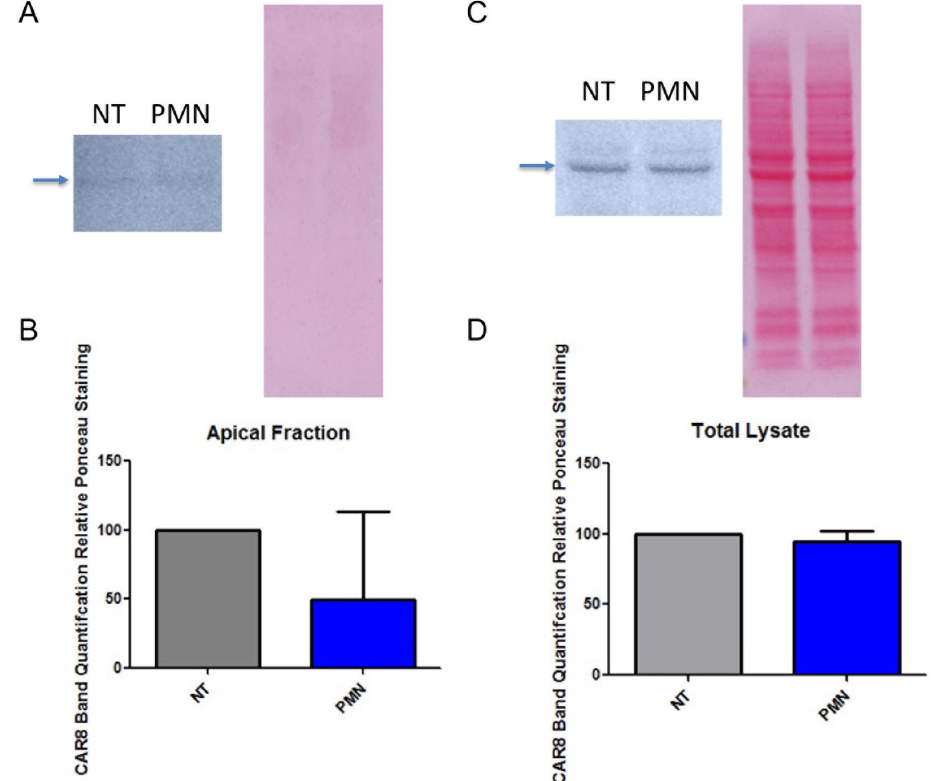
Figure 2. PMN exposure does not significantly change apical or total expression of CAR Ex8 in MDCK-CAR Ex8 epithelia. MDCK-CAR Ex8 cells were grown in 6-well transwell inserts until they were fully polarized and then exposed to PMN. Apical surface proteins were marked with sulfo-NHS-biotin and cell lysates were run through neutravidin beads to create an apical protein fraction. Cell lysates containing apical ( A ) and total ( C ) cell proteins were subjected SDS-PAGE, Ponceau staining, and subsequent Western blotting with antibody specific to CAR Ex8 . Band quantifications are depicted for apical ( B ) and total ( D ) CAR Ex8 staining relative to Ponceau loading control. Error bars represent SEM from 3 independent experiments. NT, non-treated.